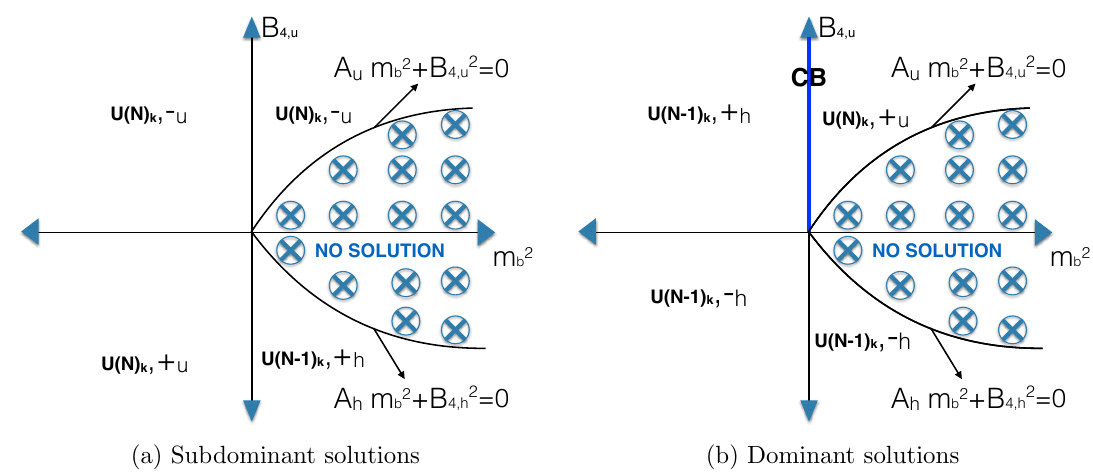
Figure 22. Graphs of the domain of existence of the dominant and subdominant solutions to the gap equation for x 6 > (cid:30) 2 . The dominant and subdominant solutions merge along the two parabolas in the graphs above. No solution region is marked with blue crosses in the (cid:12)gure. The solution space may thus be thought of as a double cover of the compliment of the uncrossed portion of the m 2 - B 4 ;u b